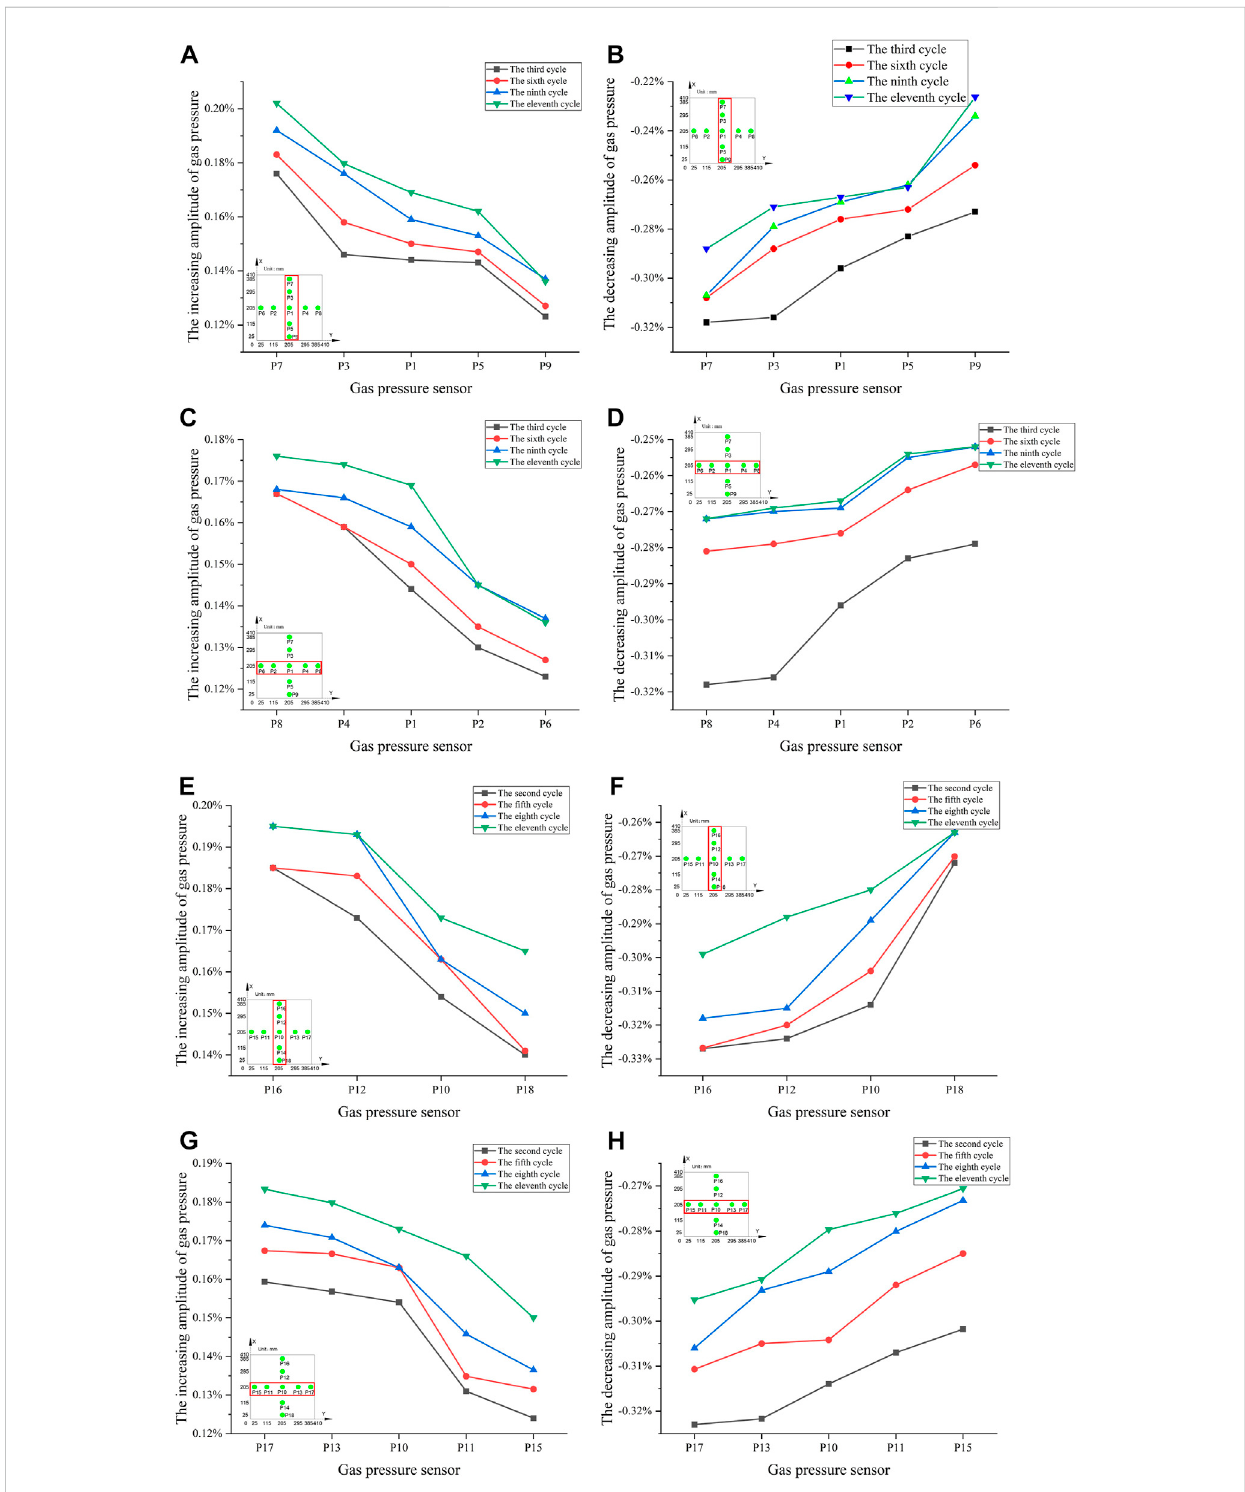
FIGURE 8 Relationship between gas pressure and cycle